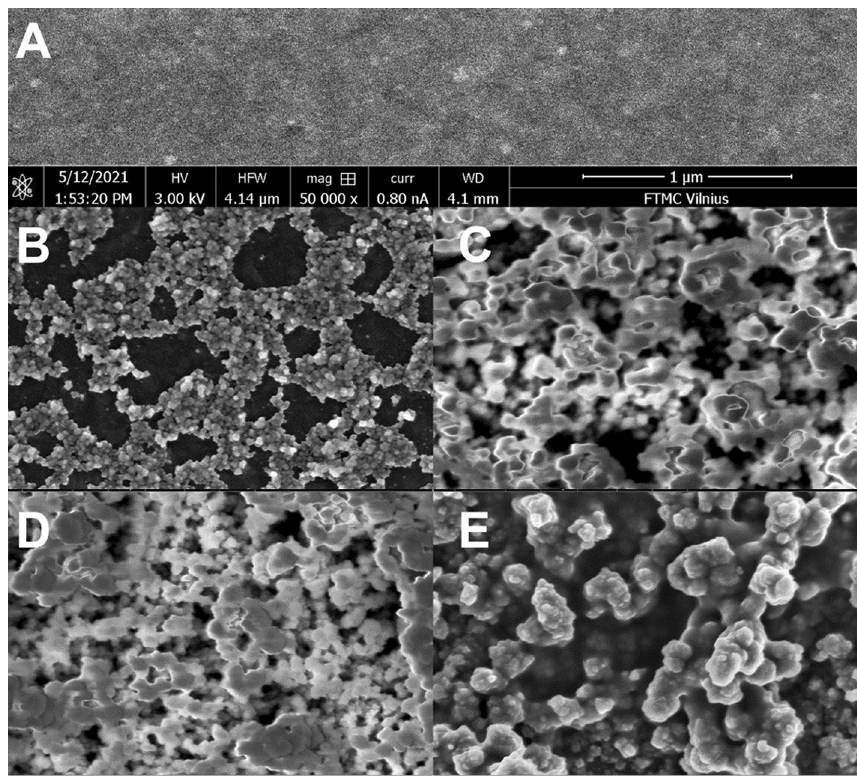
Figure 5. SEM images of GR ( A ) and GR/PB ( B ), GR/PB-PPCA ( C ), GR/PB-PPCA/PPCA ( D ) and GR/ PB-PPCA/PPCA–GOx ( E ) modified electrodes.